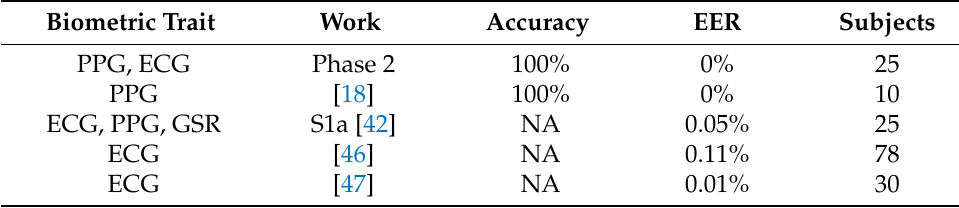
Table 4. Biometric model comparison.